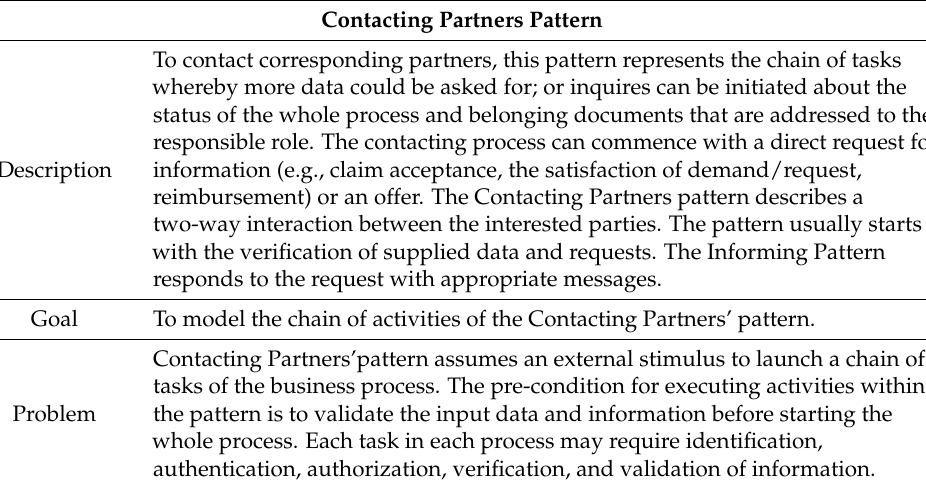
Table 2. Business Process Pattern: Contacting